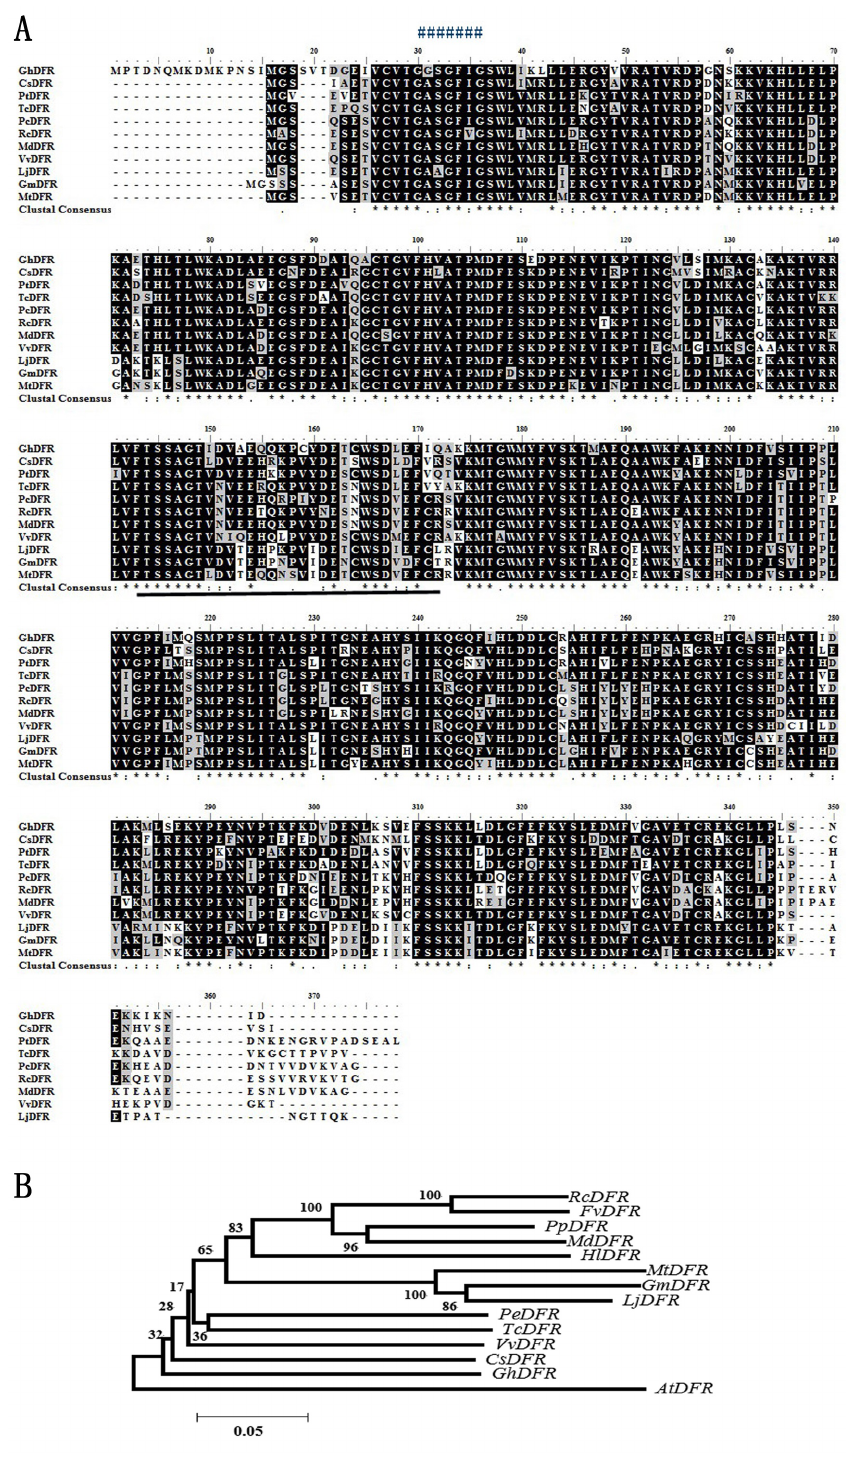
Figure 2. A sequence alignment ( A ) and a phylogenetic tree ( B ) obtained from deduced amino acid sequences of DFR homologs. ( A ) An amino acid sequence alignment was obtained from 10 deduced DFR amino acid sequences that were aligned on NCBI; ( B ) An unrooted phylogenetic tree obtained from 14 sequences. “*”: the same amino acid in all 10 sequences; “:”: conserved amino acid residues; “.”: half conserved amino acid residues; “#######”: Rossmann domain GXXGXXG; the underline showed potential domain involved in DFR substrates